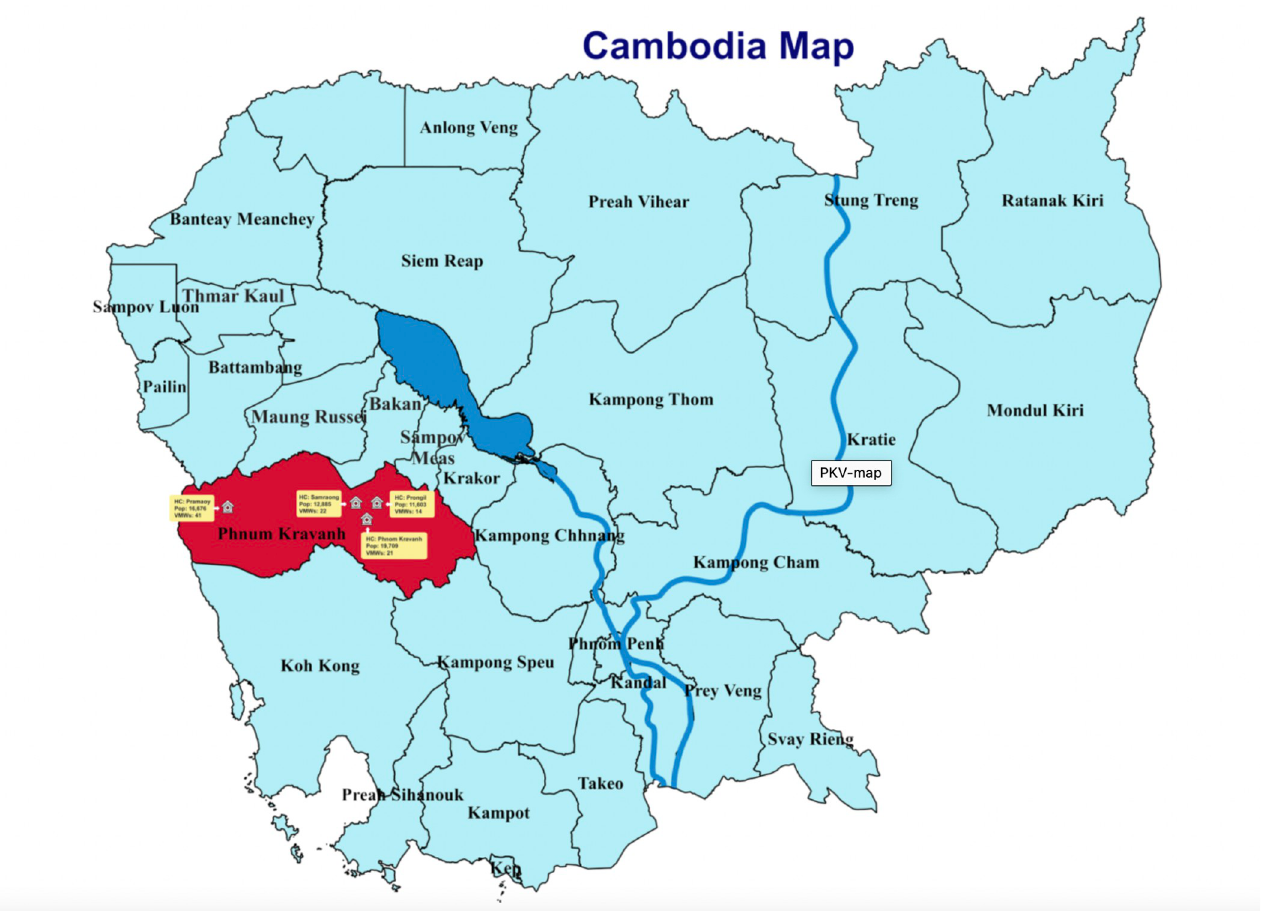
Fig 1. Map of Cambodia showing the four study HCs selected in Pursat province. This image is reproduced under a CC BY 4.0 license from https:// hsdcambodia.org/malaria/.